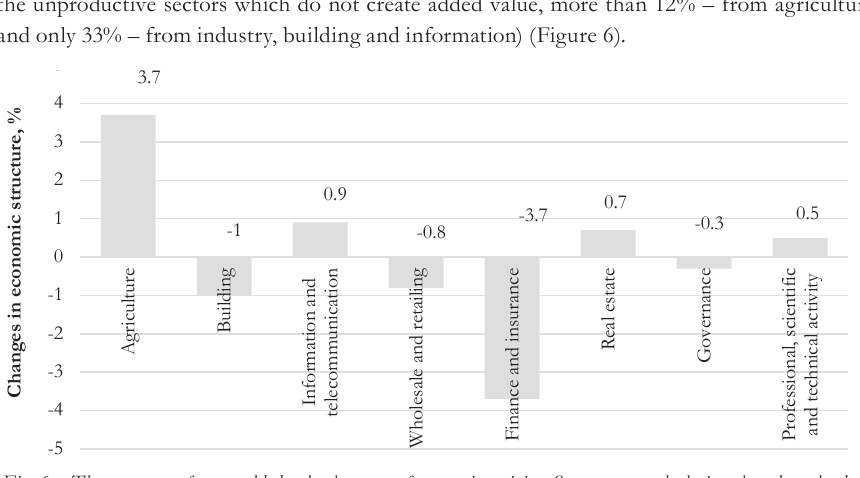
Fig. 6 – The structure of gross added value by types of economic activity. Source: own calculations based on the data from State Statistic Service of Ukraine